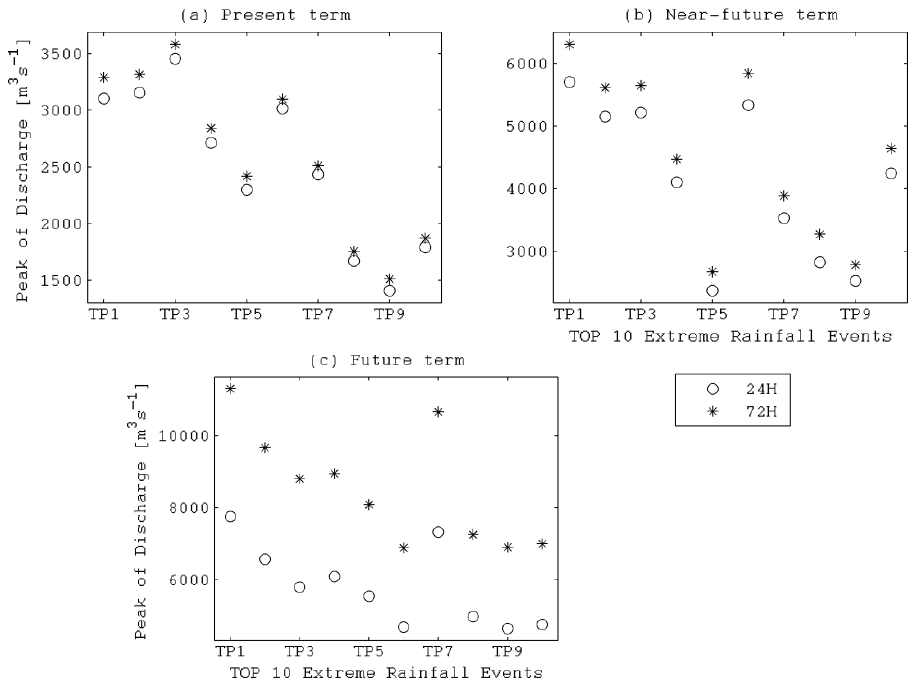
Figure 9. Peaks of discharge from TP 1 to TP 10 with the modified ranking method coefficients for each period (24 and 72 h) at the dam inlet for ( a ) Present; ( b ) Near-future; and ( c ) Future